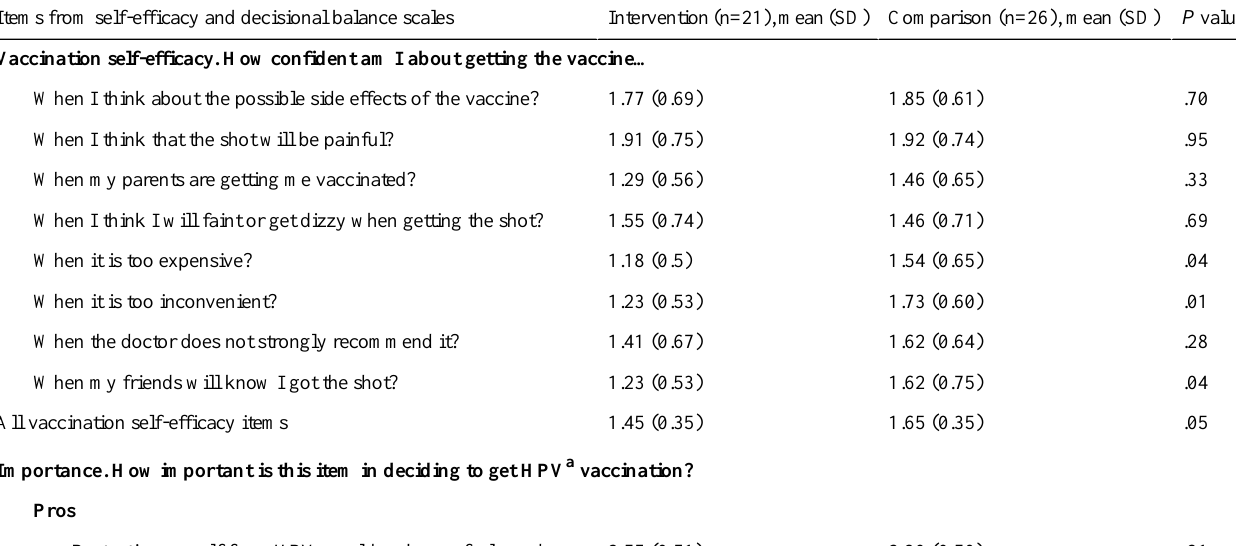
Table 1. Mean comparisons between items from the self-efficacy and decisional balance scales at post-intervention surveys. Vaccination self-efficacy. How confident am I about getting the vaccine…